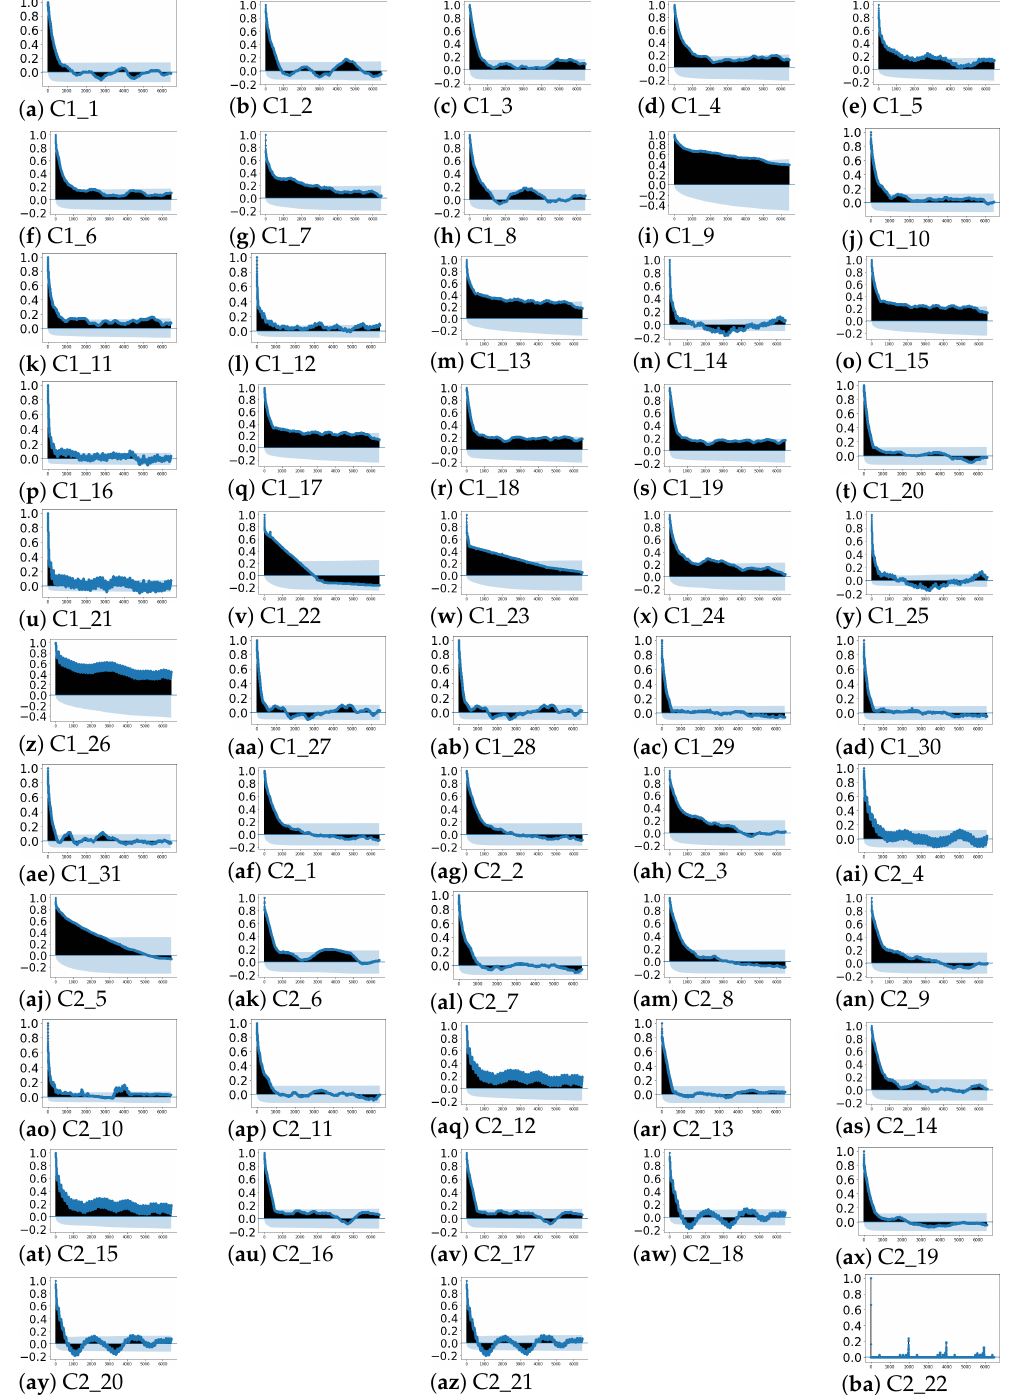
Figure 4. Auto-correlation plots of each feature of the dataset with lags up to 45